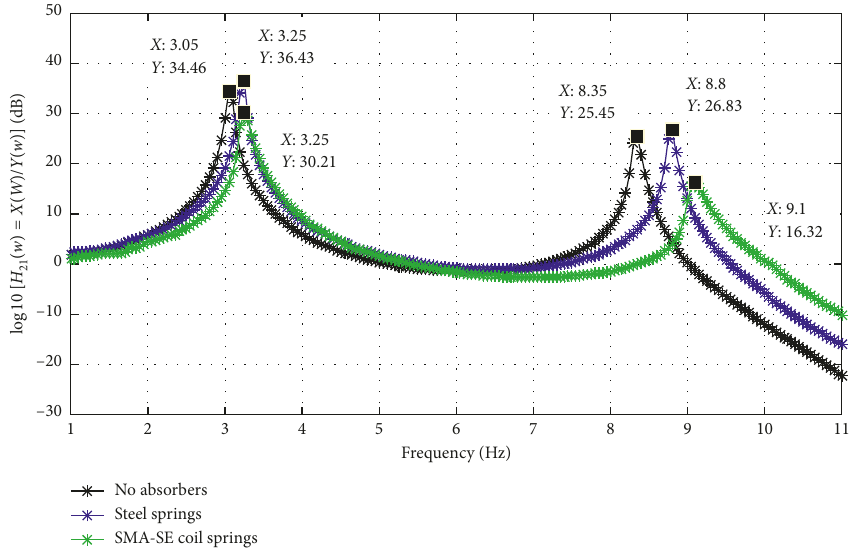
Figure 16: Experimental FRF of the second floor of the system. Table 6: Natural frequencies and displacement transmissibility in forced vibration, linear scale.